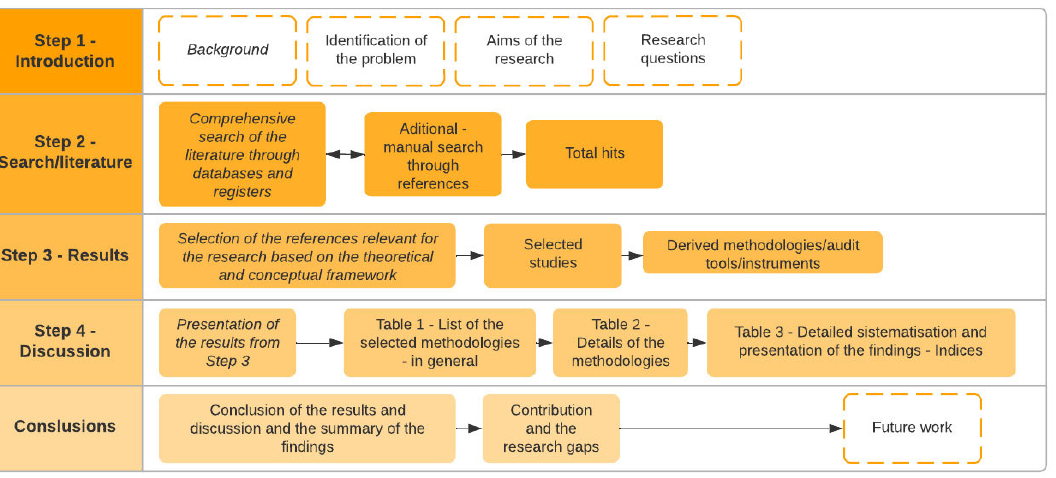
Figure 1. Flowchart of this paper’s methodology.